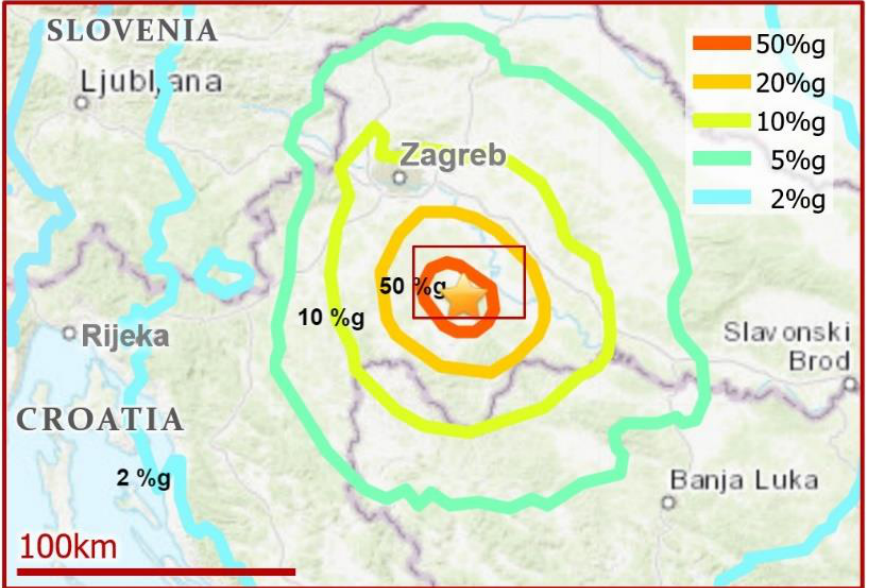
Figure 2. Peak ground acceleration of the 2020 Petrinja earthquake and the epicentre according to United States Geologic Survey [5]. Red rectangle shows the area presented in Figure 4.